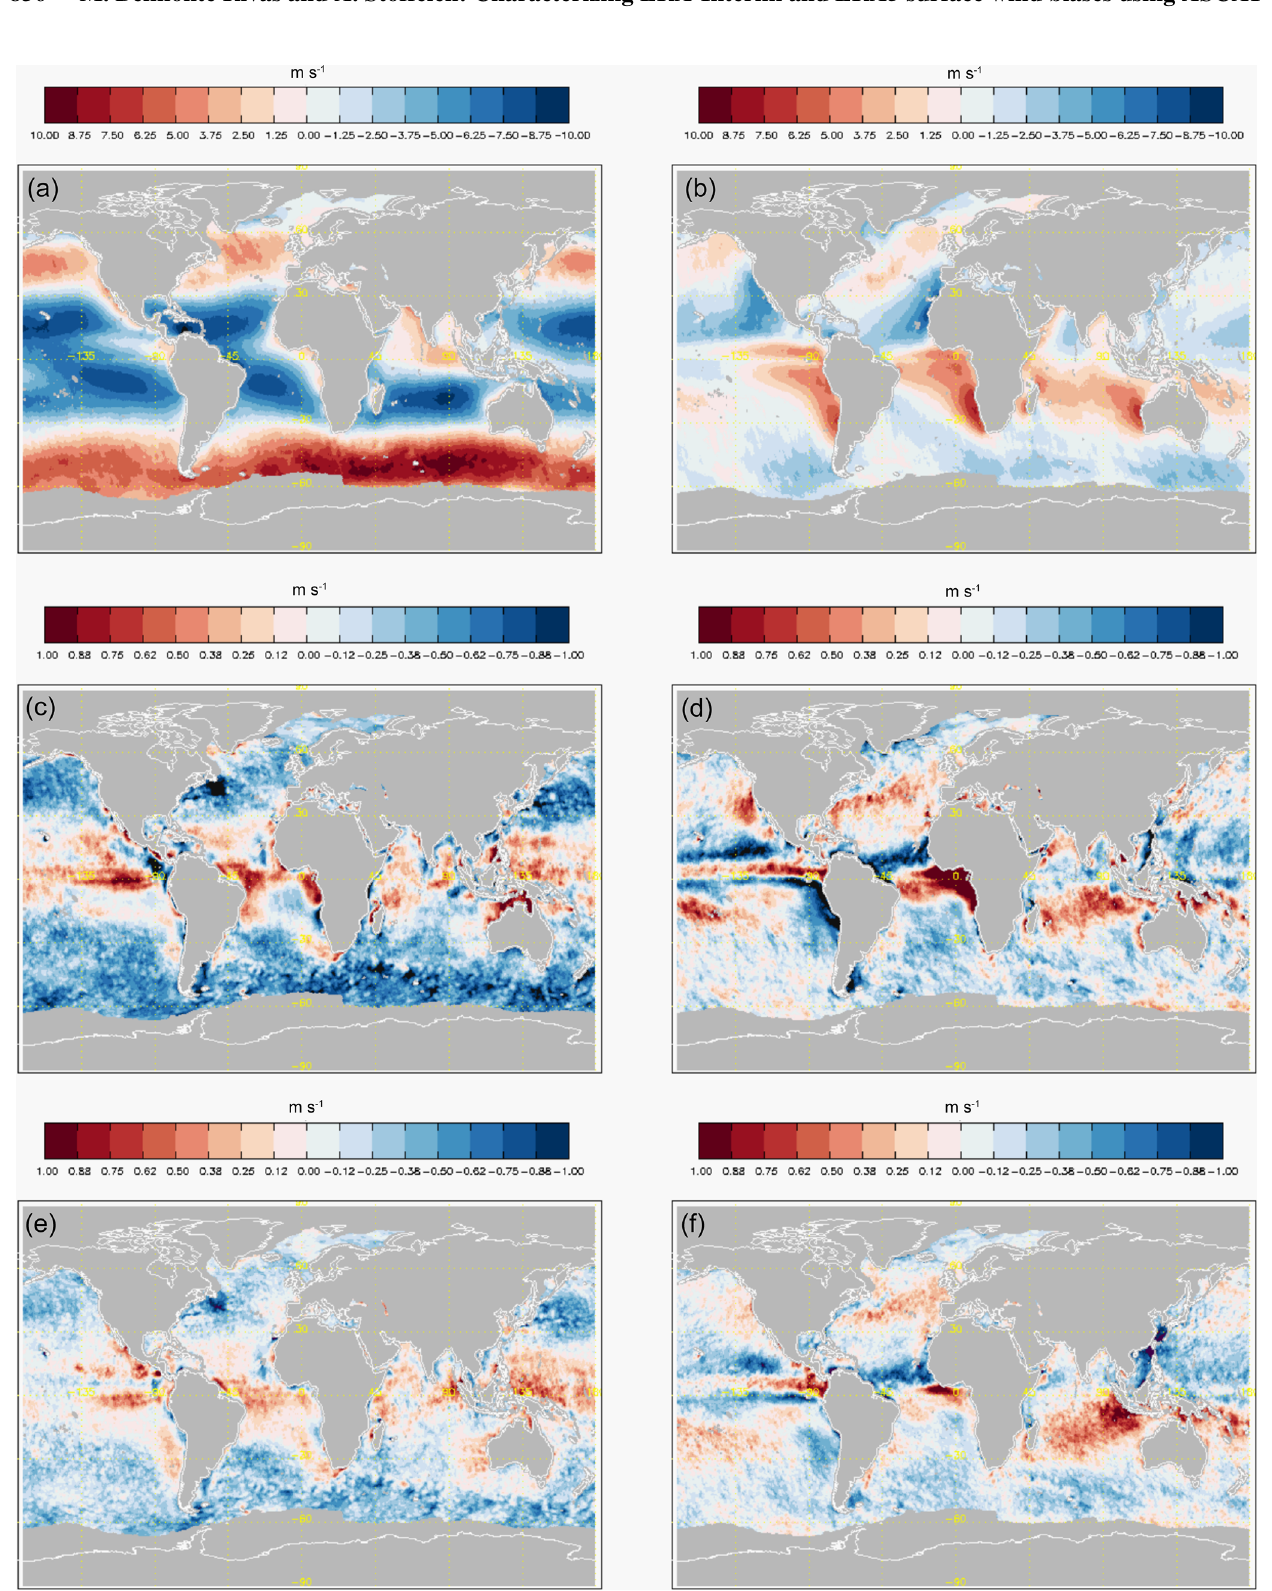
Figure 5. Global maps of annual mean zonal (a) and meridional (b) wind from ASCAT and differences from ERA-Interim (c, d) and ERA5 (e, f) first-guess winds over